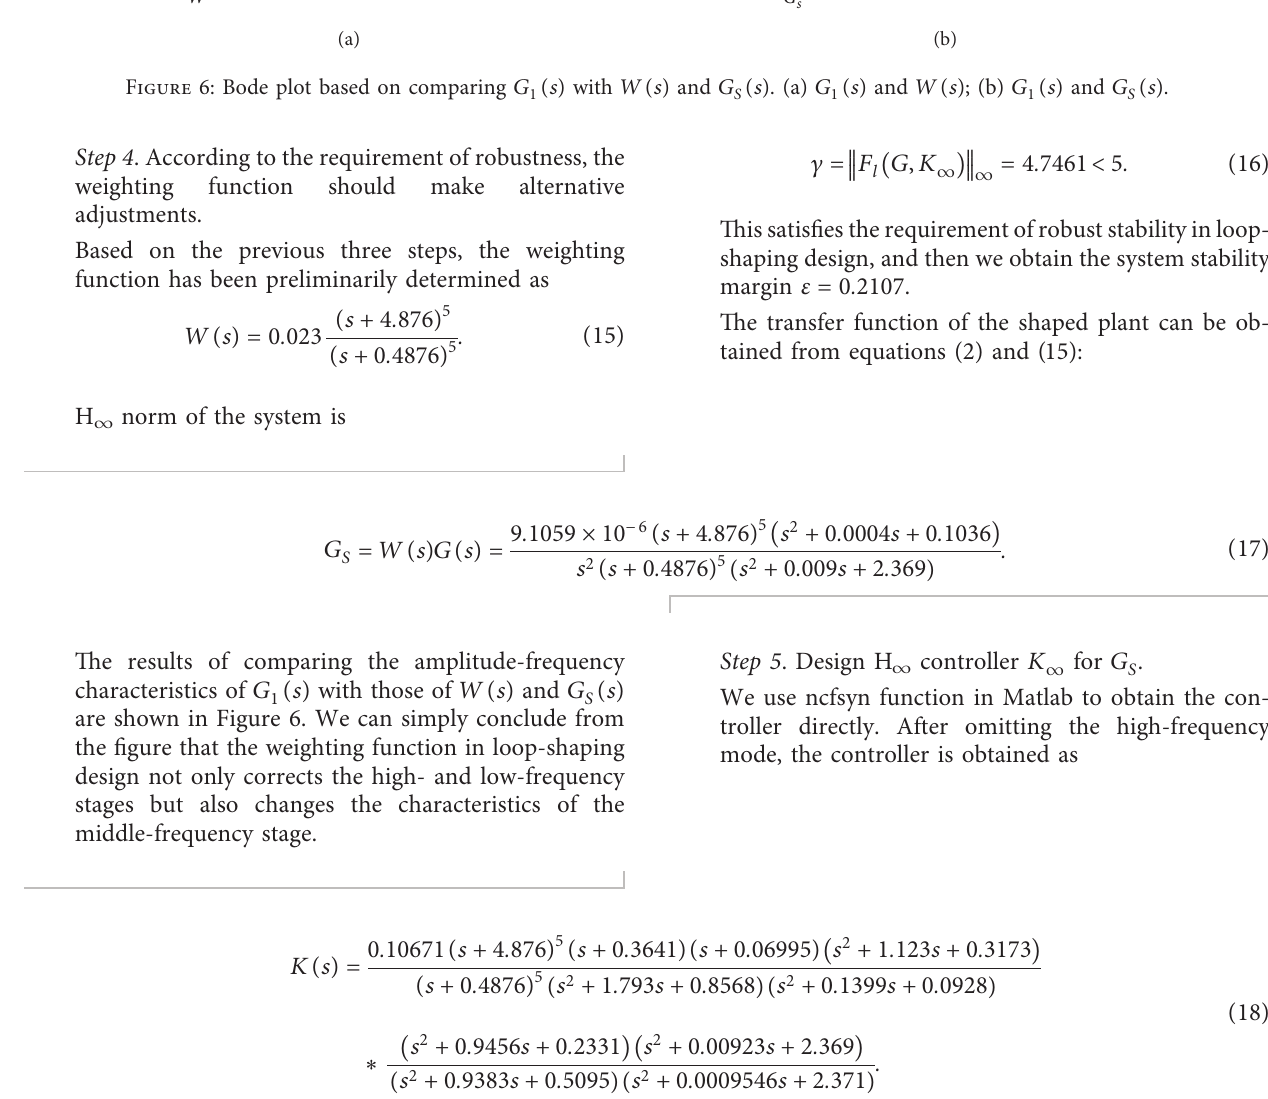
Figure 6: Bode plot based on comparing G